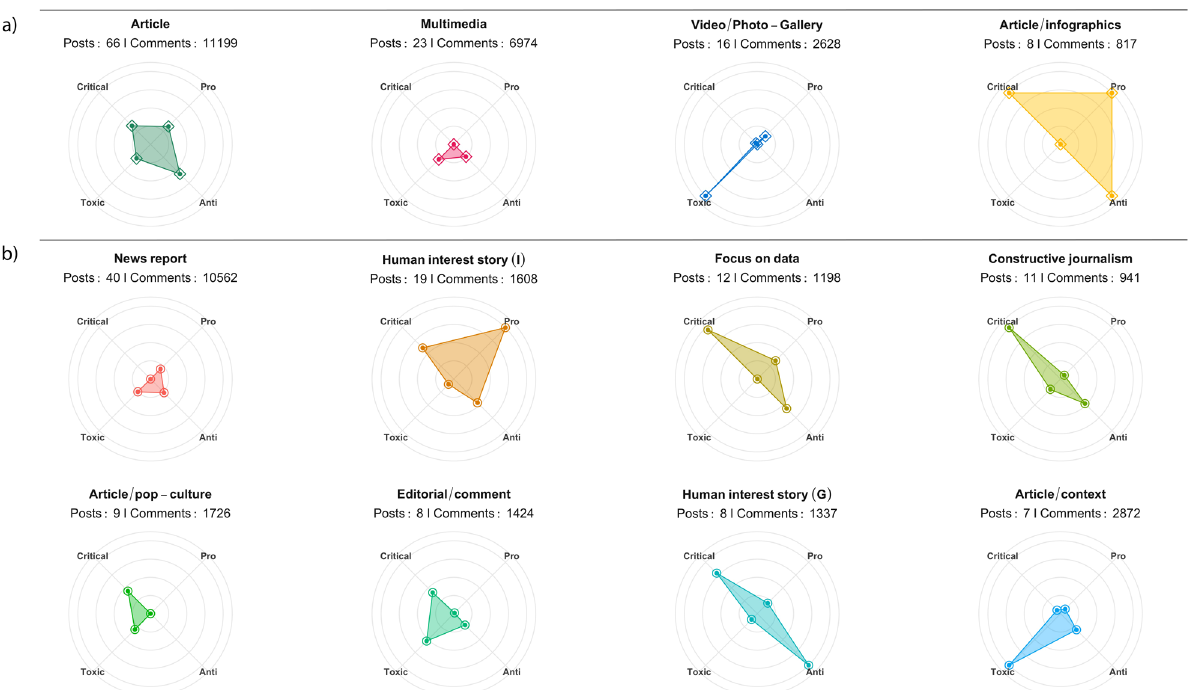
Fig. 1 Radar plots displaying the characteristic features of each content type (panel a) and journalistic technique (panel b). Each dimension respectively displays the standardized average number of critical comments, toxic comments, anti-migration comments, pro-migration comments. Features ’ values have been normalized across CT (res. JT) to ease comparison. The corresponding number of posts and comments for each CT (res. JT) are reported above each radar